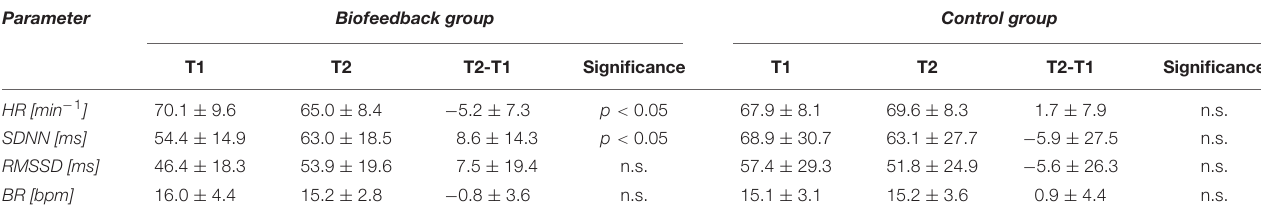
TABLE 2 | Changes of heart rate variability and breathing rate from before (T1) to after the intervention (T2) in the biofeedback and control group. Parameter Biofeedback group Control group